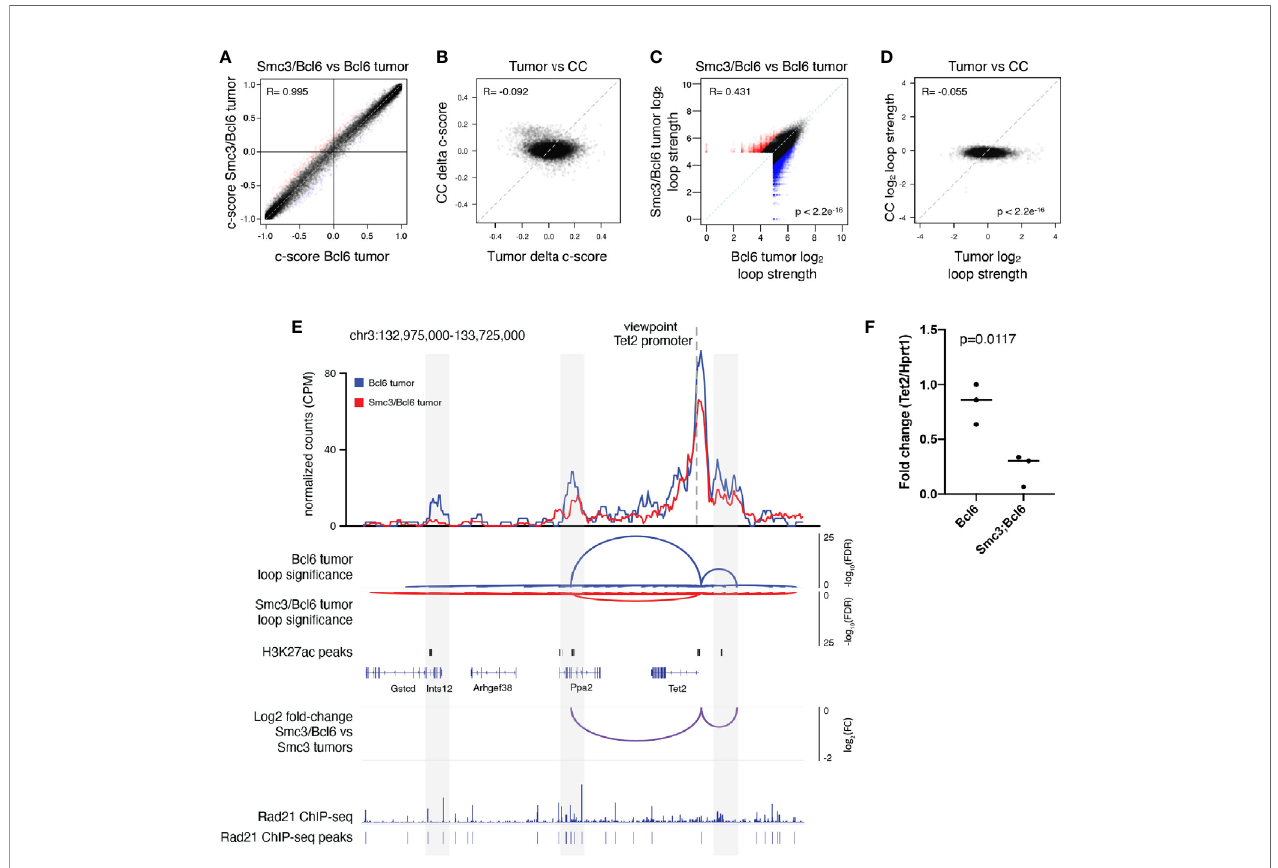
FIGURE 2 | Cohesin haploinsuf fi ciency induces loss of interactivity of promoter-enhancers at tumor suppressor genes. (A) Correlation plot between the compartment c-scores of Smc3/Bcl6 versus Bcl6 tumor cells at 100kb resolution. (B) Correlation plot for the change in compartment c-scores of Smc3/Bcl6 versus Bcl6 tumor cells and the change in compartment c-scores of Smc3 wt / – versus Smc3 wt /wt centrocytes (CC) at 100kb resolution. (C) Correlation plot for the log 2 normalized loop interactivity of Smc3/Bcl6 versus Bcl6 tumor cells at 20kb resolution. (D) Correlation plot for the log 2 fold change of normalized loop interactivity of Smc3/Bcl6 versus Bcl6 tumor cells and the log 2 fold change of normalized loop interactivity of Smc3 wt/ – versus Smc3 wt/wt centrocytes (CC) at 20kb resolution. (E) Virtual 4C analysis showing normalized interactions with the Tet2 promoter for Bcl6 tumors (blue line) and Smc3/Bcl6 tumors (red line) at 20kb resolution. Loop calling signi fi cance following the mango approach are shown for Bcl6 and Smc3/Bcl6 tumors with – log 10 (FDR). Enhancers were de fi ned as H3K27Ac peaks mapped in germinal center B cells by Mint-ChIP. Rad21 ChIP-seq was performed in the mouse lymphoma cell line CH12.LX (35). The differences between normalized interactions with the Tet2 promoter are shown as log 2 fold-change between Bcl6 and Smc3/Bcl6 tumors. (F) RT-qPCR for Tet2 mRNA in Bcl6 (n=3) and Smc3/Bcl6 (n=3) tumors, normalized to Hprt1 mRNA